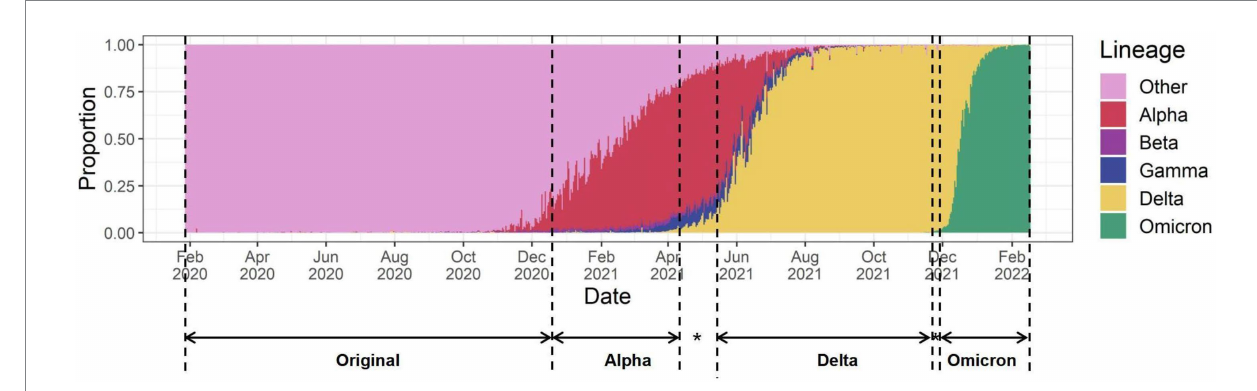
FIGURE 1 The four periods of the pandemic defined by the dominance of the different VOC strains. * A period of multiple variants mixing, with the next VOC already occurring in more than 10% of